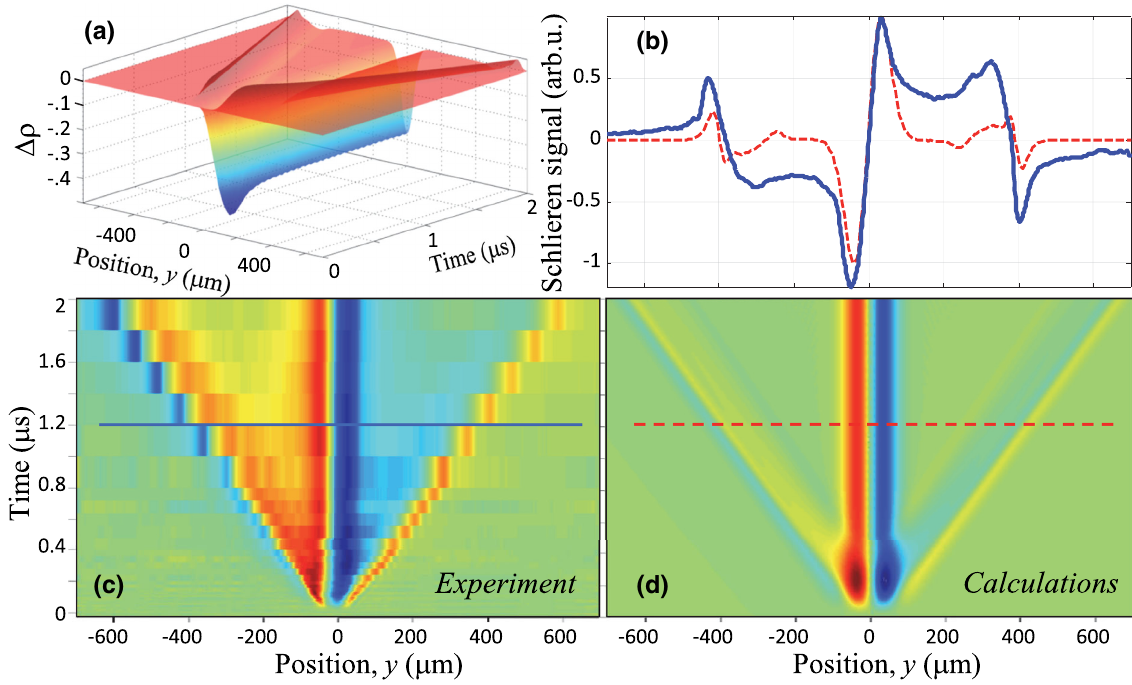
FIG. 4. Comparison of the experimental results with the numerical calculations of gas hydrodynamics. The calculated change in the gas density, Δ ρ , is shown in panel (a) as a function of time and distance. Experimentally determined parameters of the observed gyroscopic channel are used to simulate the heat source, which initiates the dynamics at point ( y ¼ 0 ; τ ¼ 0 ). In panel (b), the derivative of the calculated density profile d = d y ½ ρ ð y Þ(cid:3) at 1 . 2 μ s is compared with the y cross section of the schlieren image recorded 1 . 2 μ s after the centrifuge (dashed red and solid blue curves, respectively). The dependence of the measured and calculated schlieren signals on both space and time are shown in panels (c) and (d), respectively, with the two lines indicating the two cross sections displayed in plot